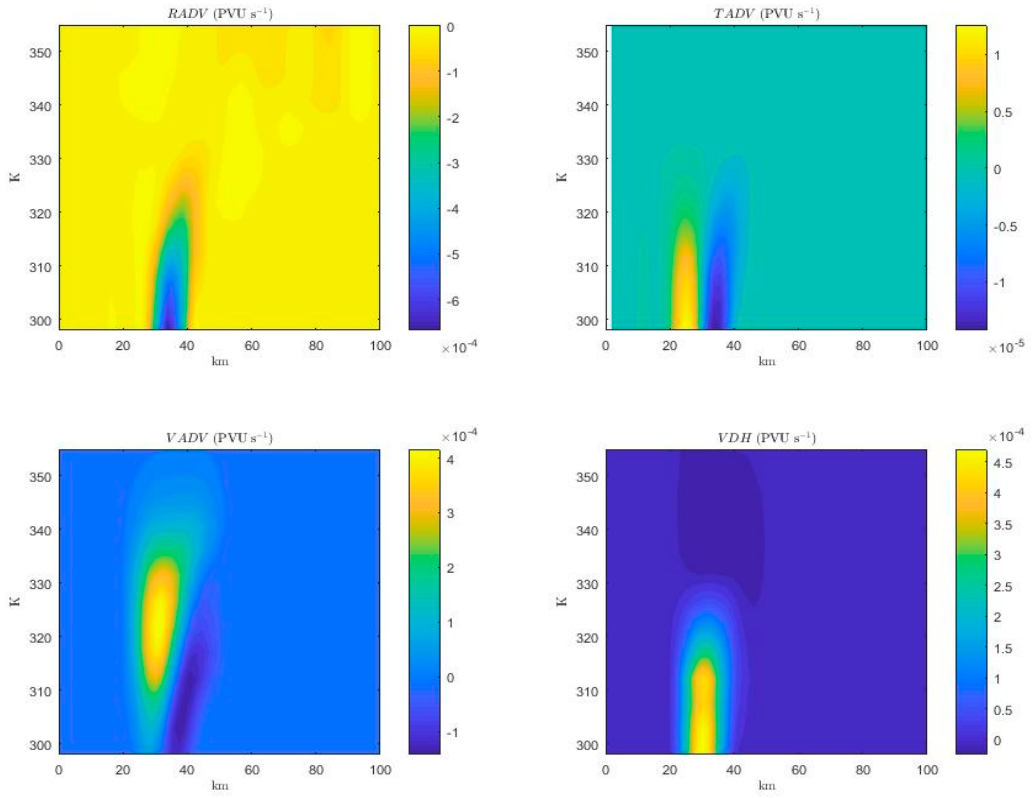
Figure 7. PV budget terms at (cid:1872) = 4 h . RADV stands for radial advection, TADV stands for azimuthal advection, VADV stands for vertical advection, and VDH stands for vertical diabatic heating term. All terms are given in units of (cid:1842)(cid:1848)(cid:1847) ⋅ s (cid:2879)(cid:2869) .